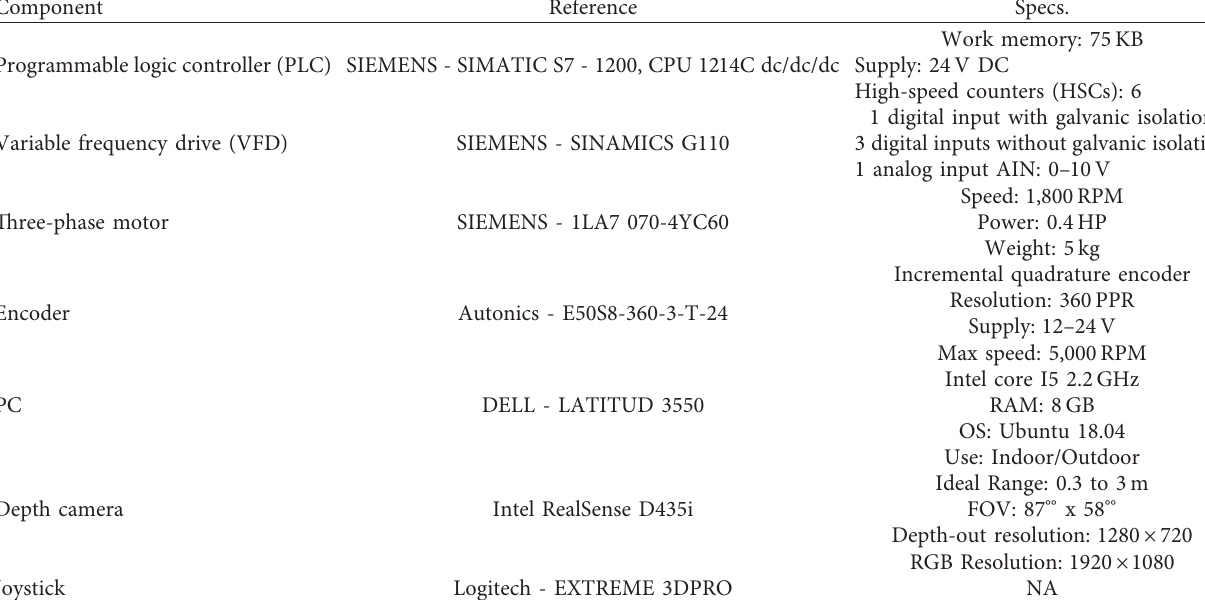
Table 3: Electrical components’ general